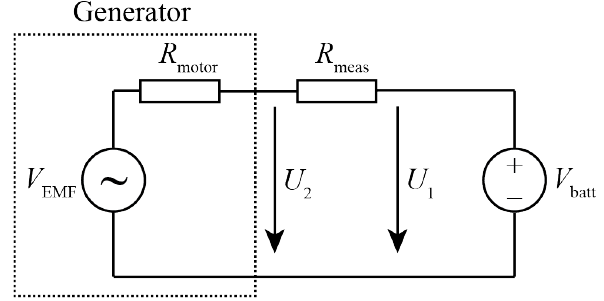
Figure 10. Equivalent circuit for the determination of V EMF